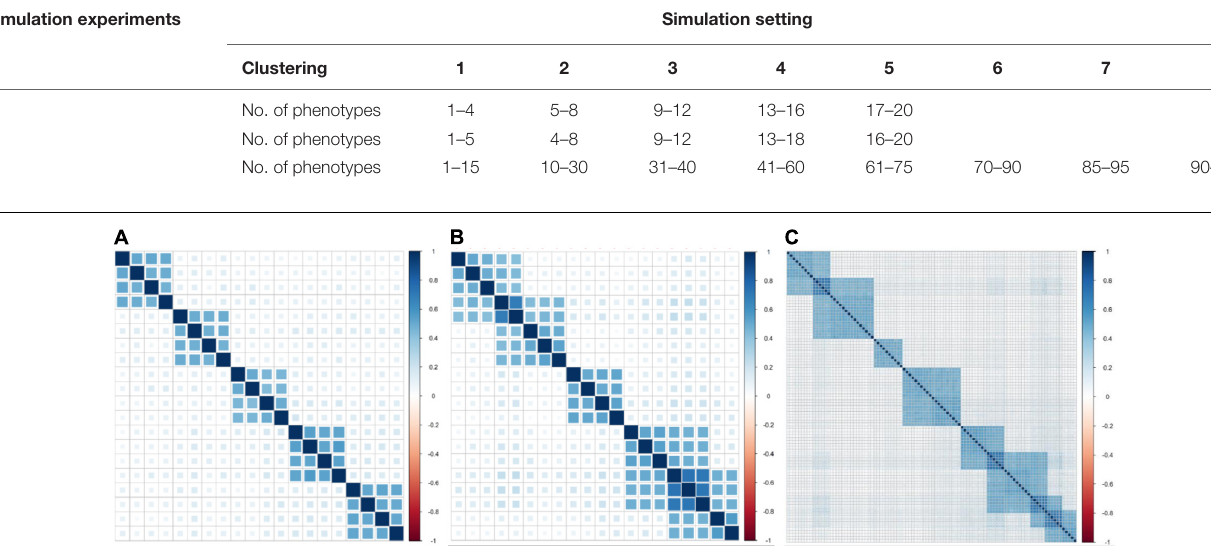
TABLE 1 | Different genetic structures for three simulation experiments, including five independent clusters (simulation I), five dependent clusters (simulation II), and eight dependent clusters of high-dimensional phenotypes (simulation III). Simulation experiments